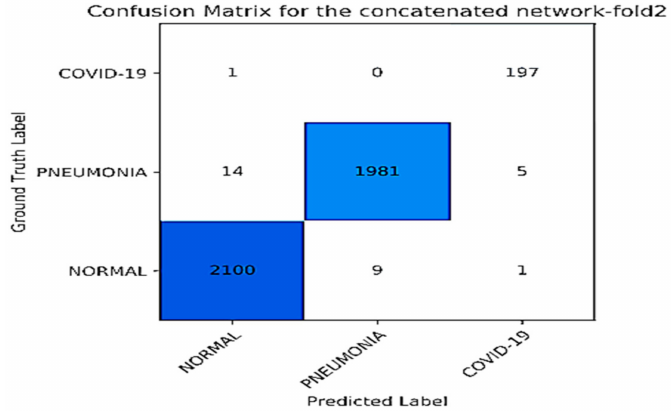
Figure 9. Confusion matrix of dataset 3.